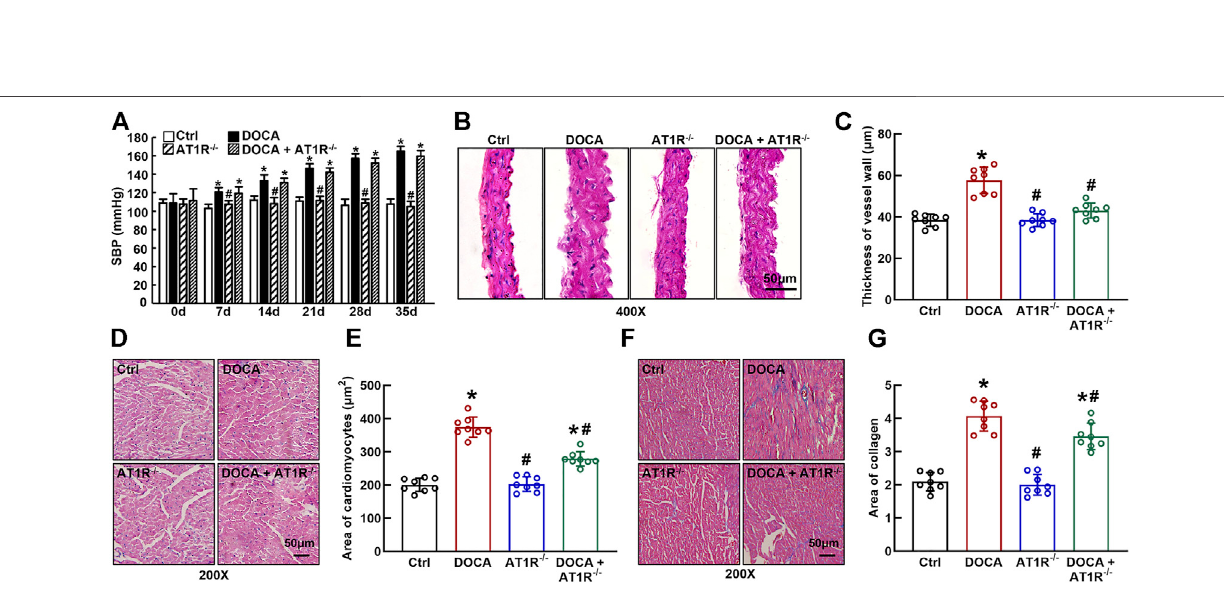
Frontiers in Pharmacology |